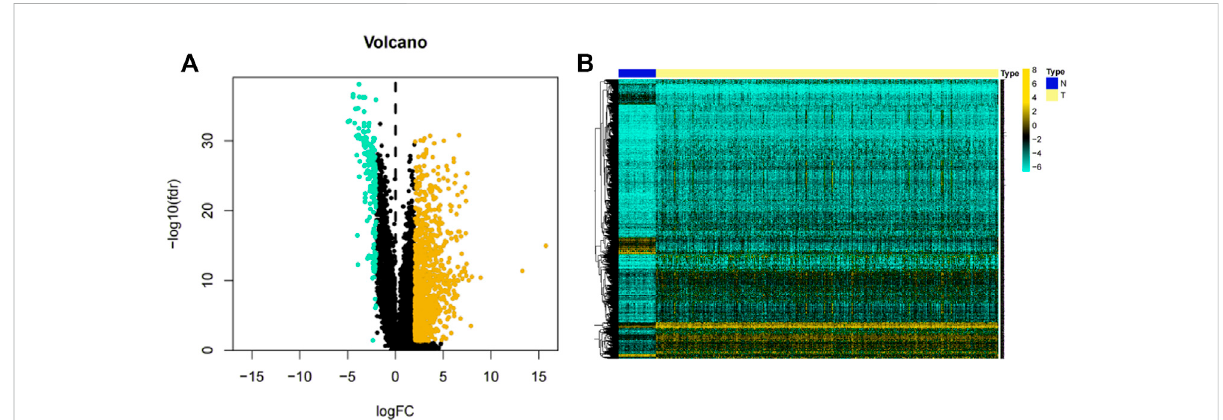
FIGURE 2 Volcano plot and heatmap of lncRNAs. (A) Volcano plot of 1,223 lncRNAs in the LUAD samples. Yellow dots represent 1,044 upregulated lncRNAs, while blue dots represent 179 downregulated lncRNAs. (B) Heatmap of 1,223 lncRNAs expression levels in LUAD samples from the TCGA- LUAD project. N = normal samples, T = LUAD